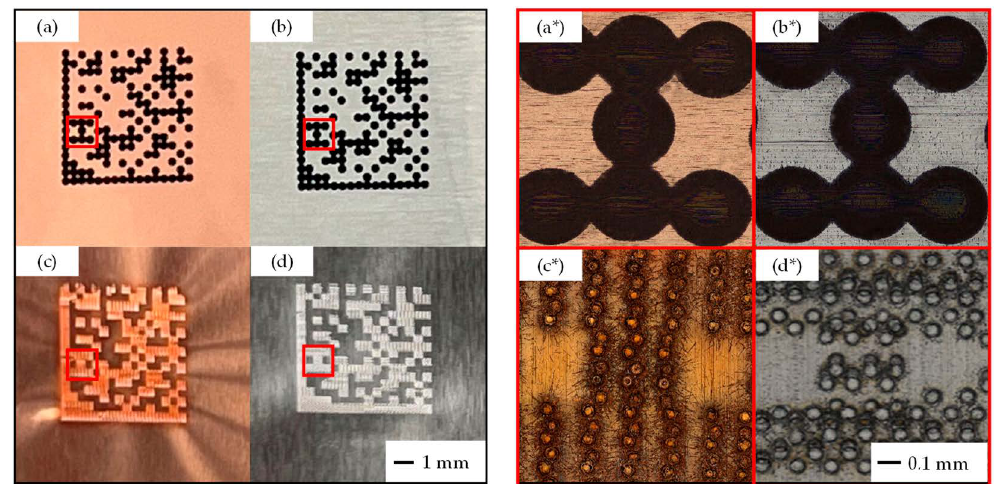
Figure 7. Left: ( a ) copper foil with ink-printed DMC, ( b ) aluminum foil with ink-printed DMC, ( c ) copper foil with laser-marked DMC, ( d ) aluminum foil with laser-marked DMC. Right: corre- sponding enlargement ( a* – d* ) of the red-outlined modules of the four codes. For a module size of 0.35 mm, the codes had a resulting size of 5.6 × 5.6 mm.